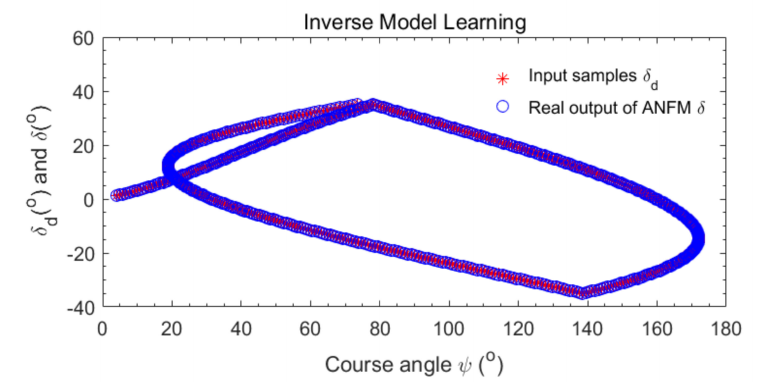
Figure 15. Input samples curve of sawtooth wave.